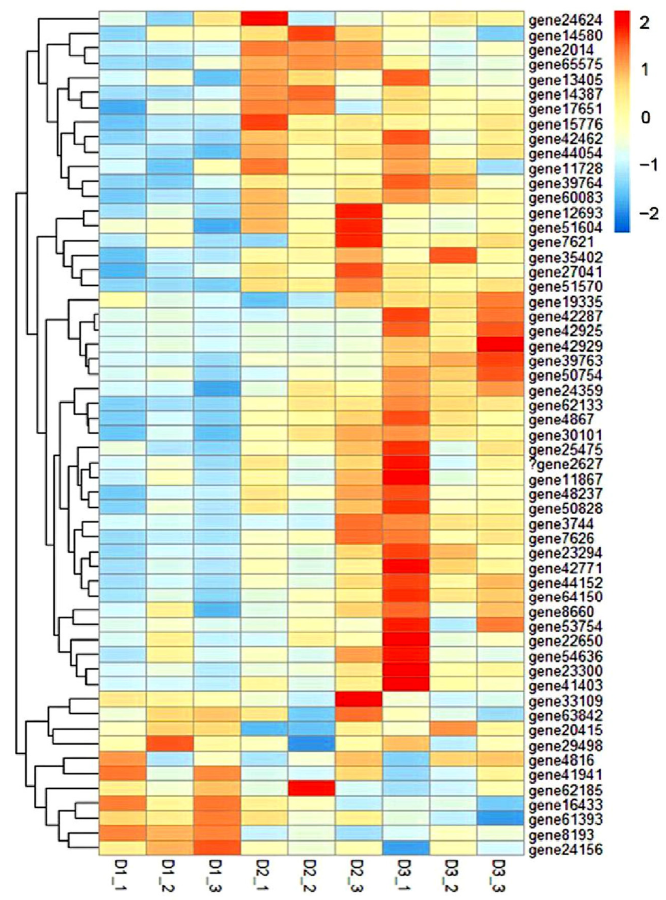
Figure 2. Clustered heat map of the expression of genes related to myofiber development in common carp fed with diets D1–D3. The distance algorithm (inter-sample Spearman and inter-gene Pearson correlation coefficients) was used for cluster analysis. Transcript enrichment is indicated in the heat map from low (blue) to high (red), as shown in the colored groups to the right of the heat map. The top 15 enriched KEGG pathways between D1 versus D2 (Supplementary Mate- rials Figure S3A), D1 versus D3 (Supplementary Materials Figure S3B) were the ribosome, FoxO signaling pathways, oxidative phosphorylation, Parkinson’s disease, non-alcoholic fatty liver disease (NAFLD), circadian, rhythm, and microRNAs in cancer. Interestingly, the FoxO signaling pathways were both presented in D1 versus D2, and D1 versus D3. As shown in the FoxO signaling pathways (Supplementary Materials Figure S4), the FoxO was mainly regulated by 3 pathways, which include two negative regulatory pathways (MAPK and PI3K) and one positive regulatory pathway (AMPK). Specifically, compared to the D1 group, the MAPK ( egfr , grb2 , sos , ras , raf , mek , and erk ) and PI3K ( pi3k and sgk ) pathway components were up-regulated, and the AMPK pathway was down-regulated with the D2 and D3 dietary treatments. Additionally, the down-regulation of foxo was detected in the D3 treatment compared with that in the D1 treatment ( p < 0.05). In addition, 43 DEGs related to the FoxO signaling pathway also showed a distinct expression pattern among the different groups (Figure 3 and Table S4). Specifically, 29 DEGs, including the MAPK and PI3K pathway components, and insulin receptors, were